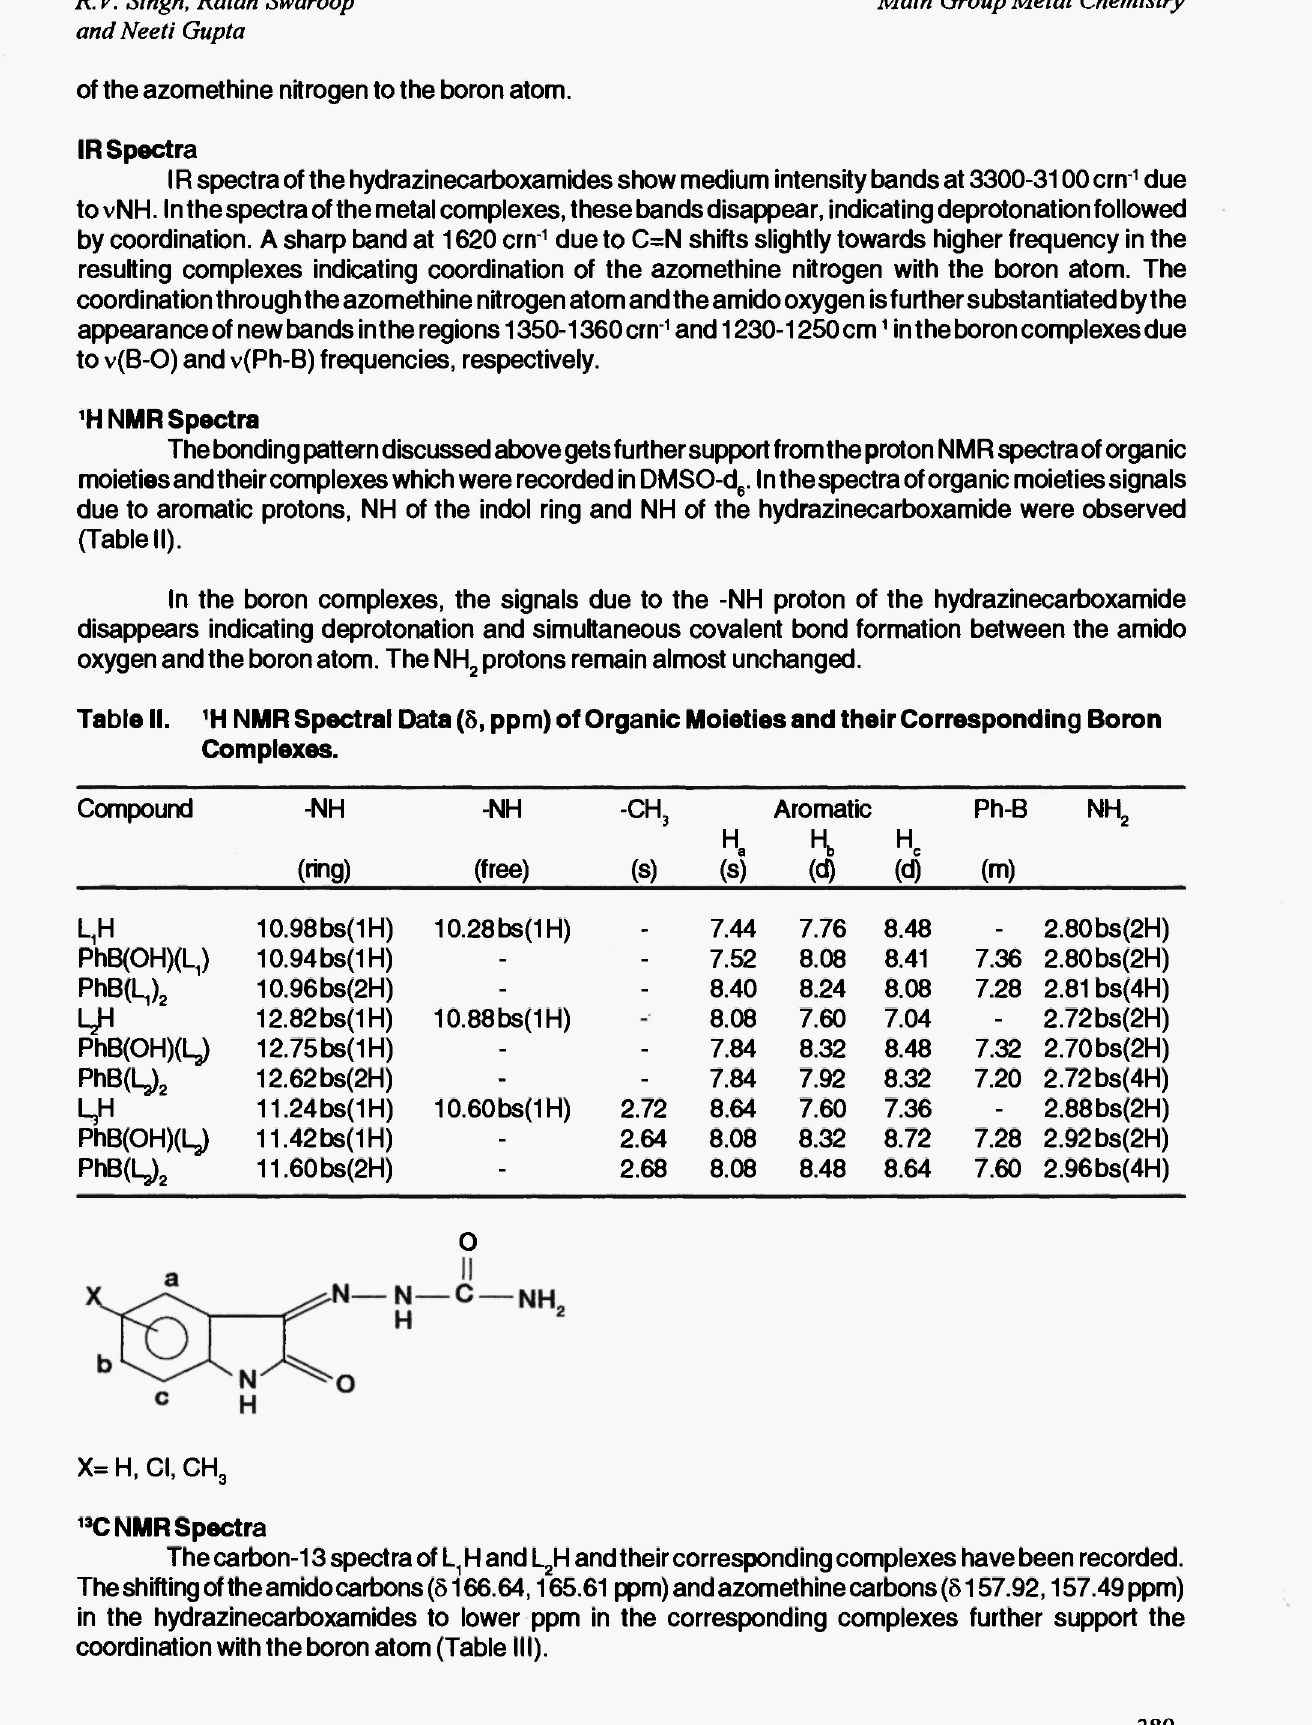
Ή NMR Spectral Data (δ, ppm) of Organic Moieties and their Corresponding Boron